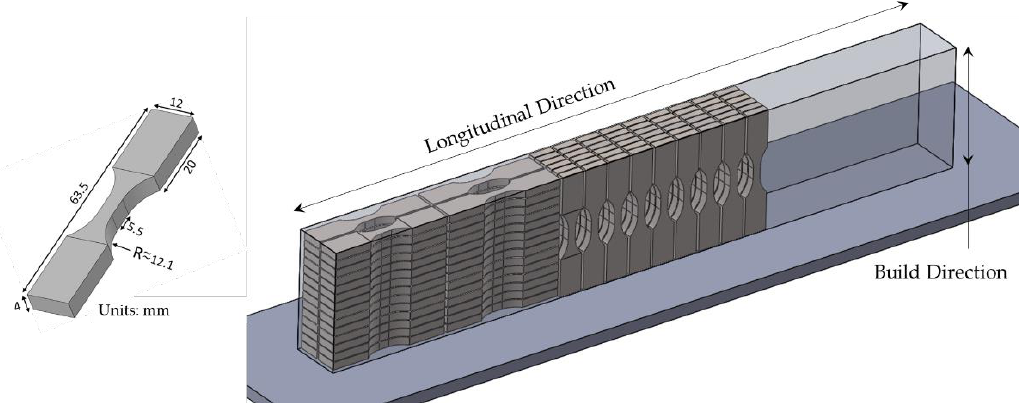
Figure 1. Sample geometry and layout from within the additive friction stir-deposition (AFS-D) build. Both the monotonic and fatigue experiments were carried out on a servo hydraulic load frame.